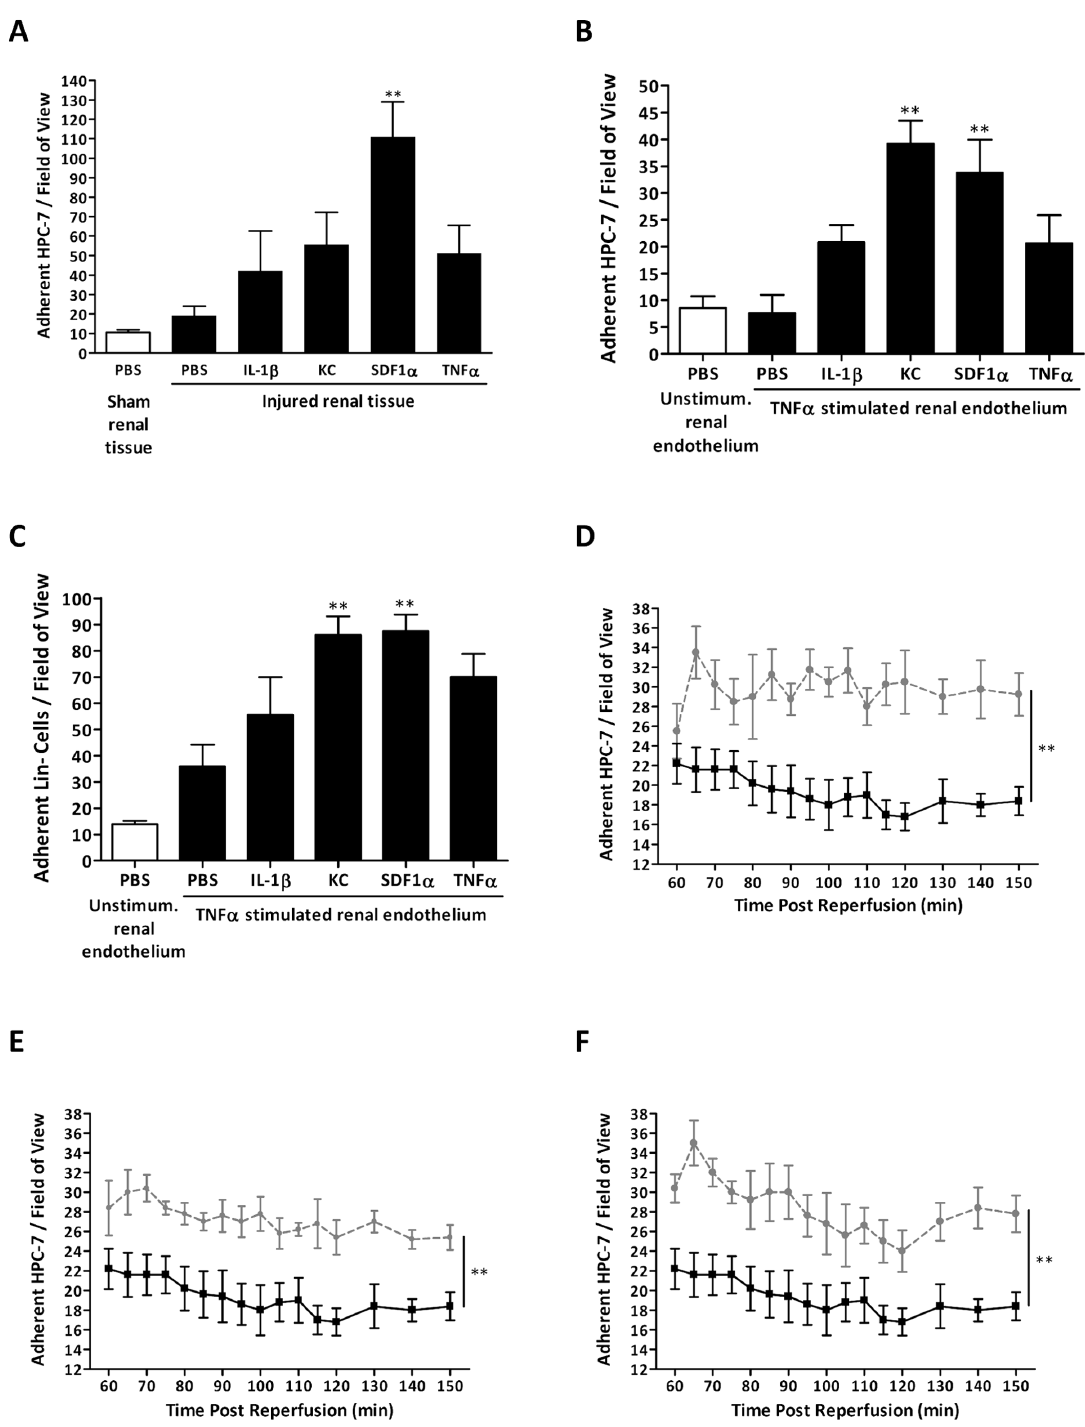
Figure 4. HPC-7 adhesion can be enhanced by pre-treating them with KC and SDF-1 a . Only HPC-7 pre-treatment with SDF-1 a (25 ng/ml; 5 minutes) significantly increased HPC-7 adhesion to IR injured frozen renal tissue when compared to PBS control (A). Pre-treatment with KC (25 ng/ ml; 5 minutes) and SDF-1 a (25 ng/ml; 5 minutes) significantly increased HPC-7 adhesion to TNF a (100 ng/ml; 4 hours) activated murine renal endothelium compared to the PBS control (B). Pre-treatment of primary murine lineage negative cells also yielded similar results. Both KC and SDF-1 a significantly increased Lin 2 cell adhesion to TNF a activated renal endothelium (C). Pre-treating with KC (D), SDF-1 a (E) or KC + SDF-1 a (F) significantly increased HPC-7 adhesion within IR injured kidney in vivo , although dual pre-treatment did not confer a greater effect. For line graphs: PBS pre- treated HPC-7 + IR kidney = solid line; KC and/or SDF-1 a pre-treated HPC-7 s + IR injured kidney = dashed line. Results are presented as mean 6 SEM (n $ 4). **p , 0.01.